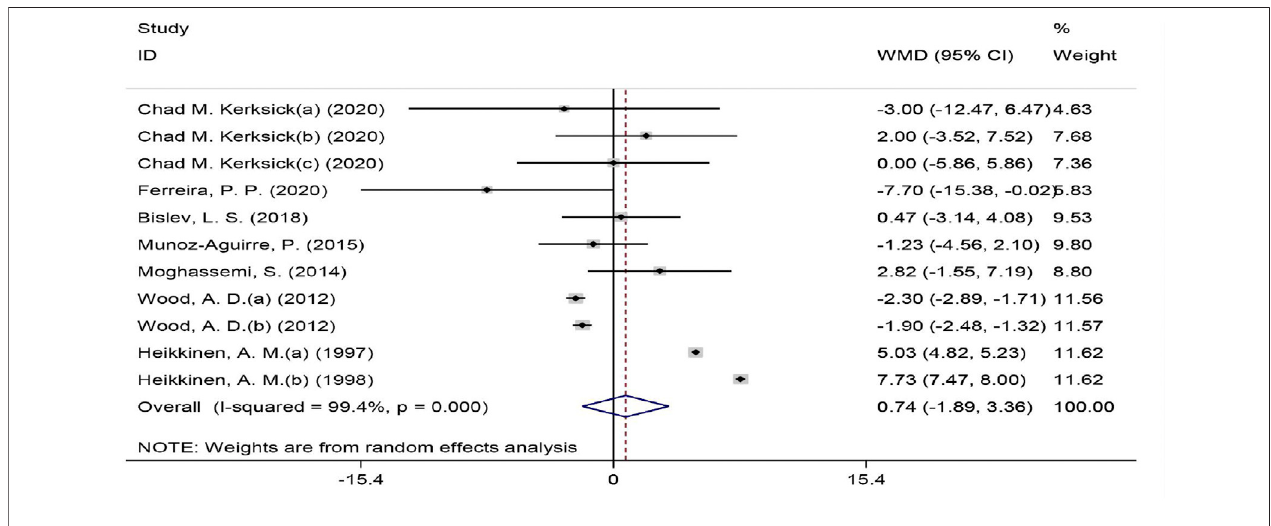
FIGURE 2 | Forest plot of the randomized controlled trials investigating the effects of vitamin D on LDL-C.